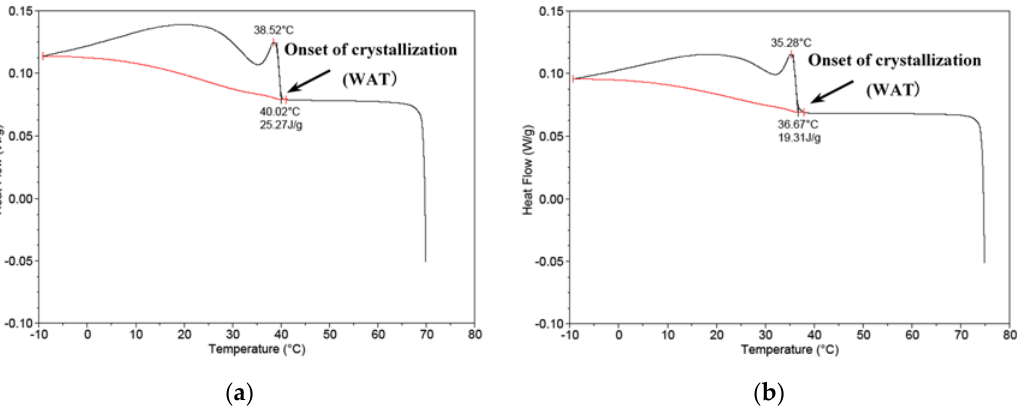
Figure 7. Thermogram for oil before and after the drag ‐ reducing surfactant addition: ( a ) initial waxy crude oil, ( b ) adding biobased surfactant of 100 mg/L. WAT, wax appearance